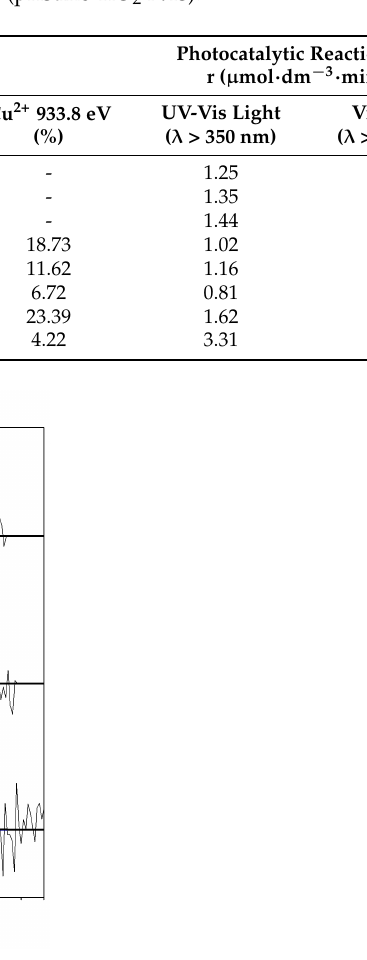
Table 2. Surface properties and photoactivity of TiO 2 /Cu x O y NTs and reference samples (pristine TiO 2 NTs).